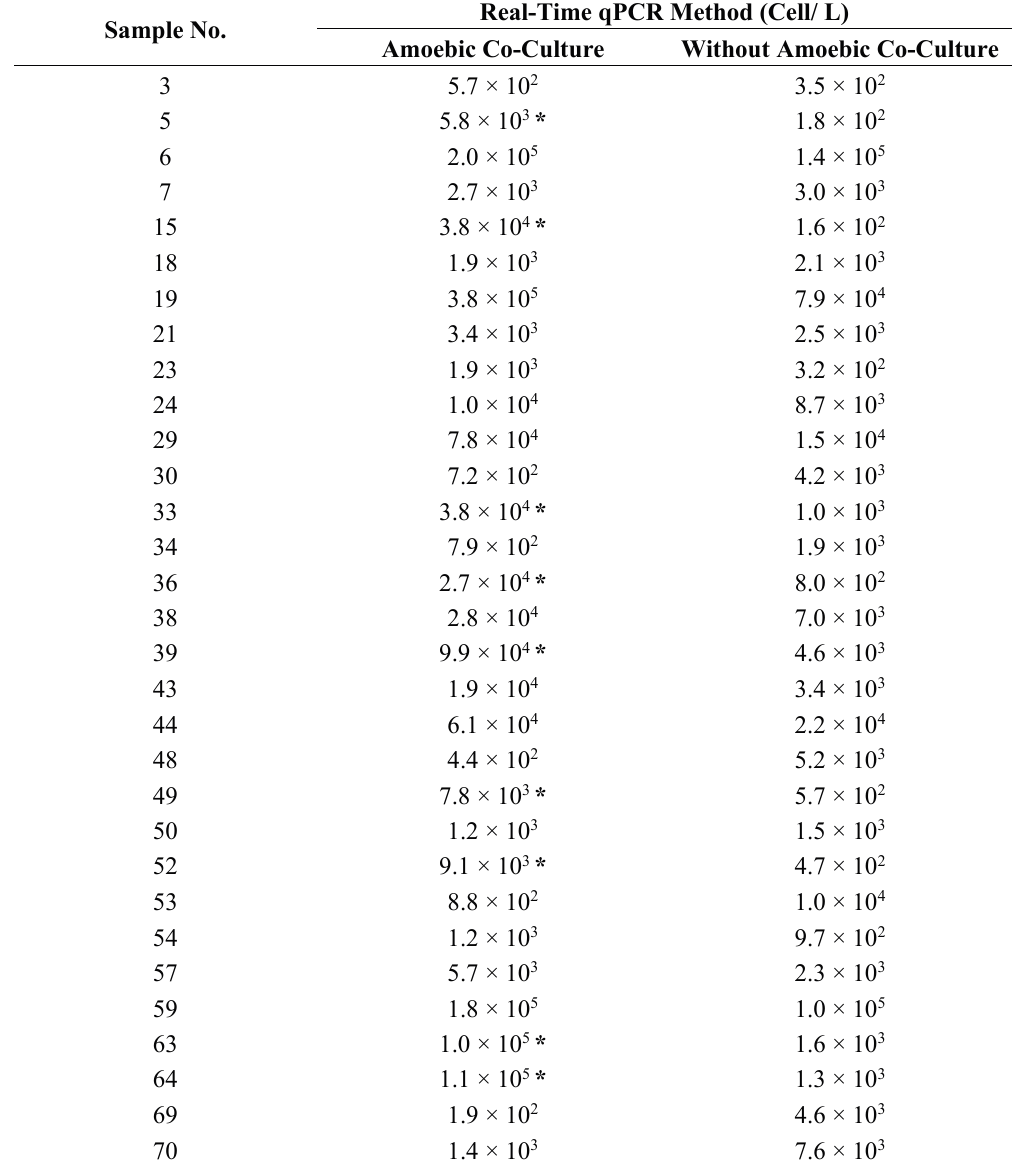
Table 2. Results of the real-time qPCR in the culture-negative 31 bath water samples. Sample No.